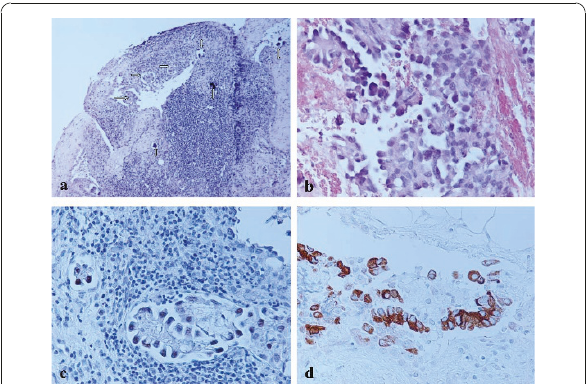
(Figure 3). The latter was observed as papillary struc- tures with tufts that lacked a central fibrovascular core.